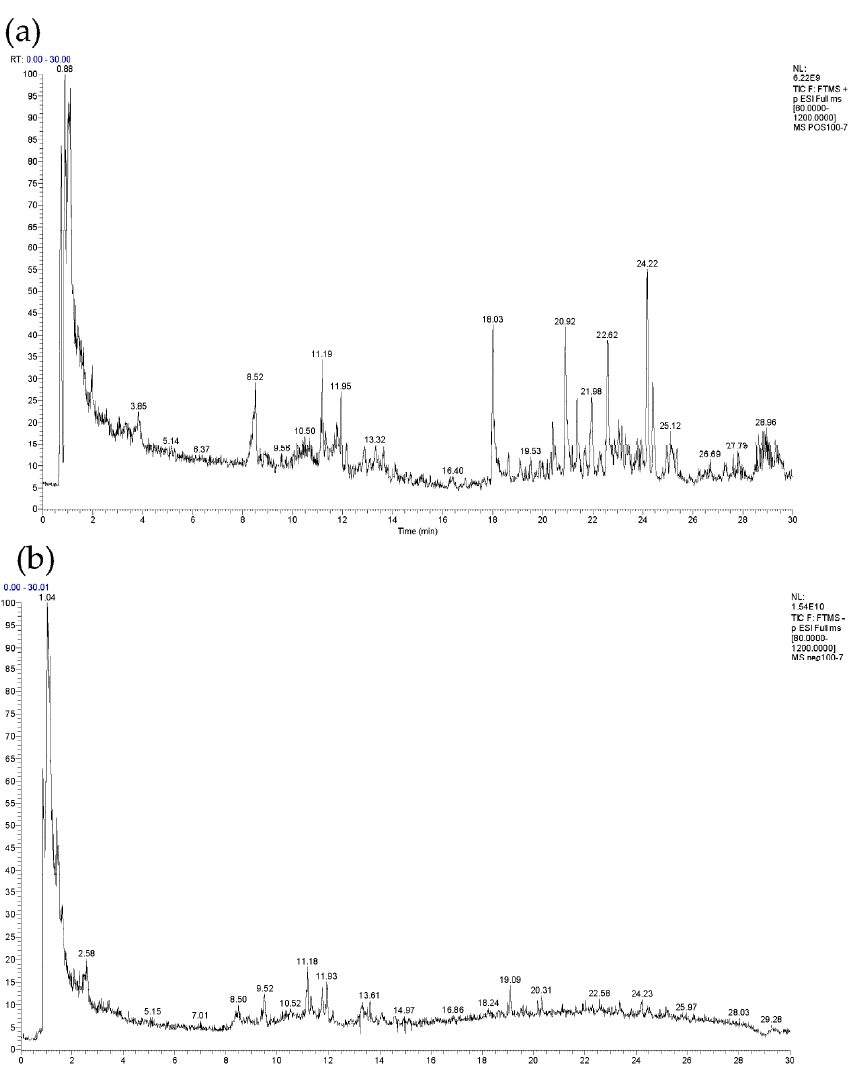
Figure 1. TIC spectrum of COMF extract: ( a ) ESI (+) -TIC scanning mass spectrometry; ( b ) ESI ( − ) -TIC scanning mass spectrometry.